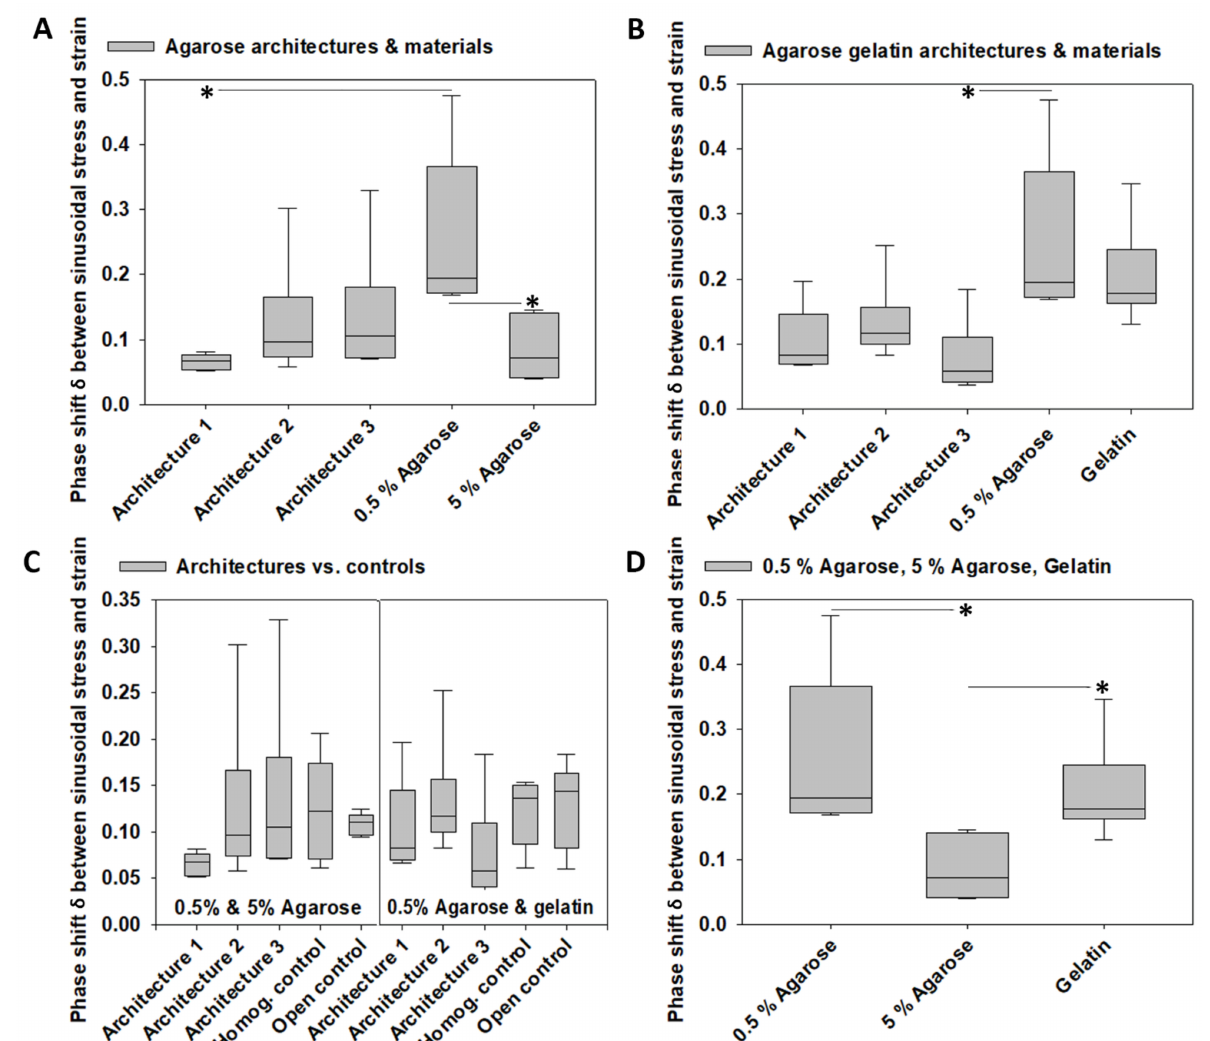
Figure 5. Mechanical characterization of the phase shift as an indicator of the viscoelasticity of the tested model sys- tems, controls, and materials used for fabrication . ( A ) Phase shift of the architectures 1, 2, and 3 of the 0.5% and 5% agarose model system and of the biomaterials used for fabrication. ( B ) Phase shift of the architectures 1, 2, and 3 of the 0.5% agarose gelatin model system and of the biomaterials used for fabrication. ( C ) Phase shift of all architectures of both agarose model systems and agarose gelatin model systems determined in ( A , B ) as well as their associated homogeneously mixed controls and open controls. Those were fabricated by cutting the stiff rings of architecture 1 into pieces and distributing them within the softer biomaterial, leading to an unconfined situation. ( D ) Phase shift of all individual materials used for model system fabrication. The box plots give the median and the 25th and 75th percentiles. The whiskers give the 10th and 90th percentiles, and the round symbols indicate outliers if present. The dark gray lines and the asterisks (*) indicate differences at p < 0.05 identified in ANOVA or ANOVA on ranks and pairwise multiple comparison procedures, such as the Newman–Keuls or Dunn’s method. Number of 0.5% and 5% agarose architecture 1, 2, and 3 model systems: n = 6 each, number of 0.5% and 5% agarose homogeneous controls: n = 5, number of 0.5% and 5% agarose open controls, 0.5% and 5% agarose material samples: n = 6 each, number of 0.5% agarose and gelatin architecture 1 model systems: n = 5, number of 0.5% agarose and gelatin architecture 2 and 3 model systems: n = 6 each, number of 0.5% agarose and gelatin homogeneous and open controls: n = 6 each, number of 0.5% agarose material samples: n = 6, number of gelatin material samples: n =